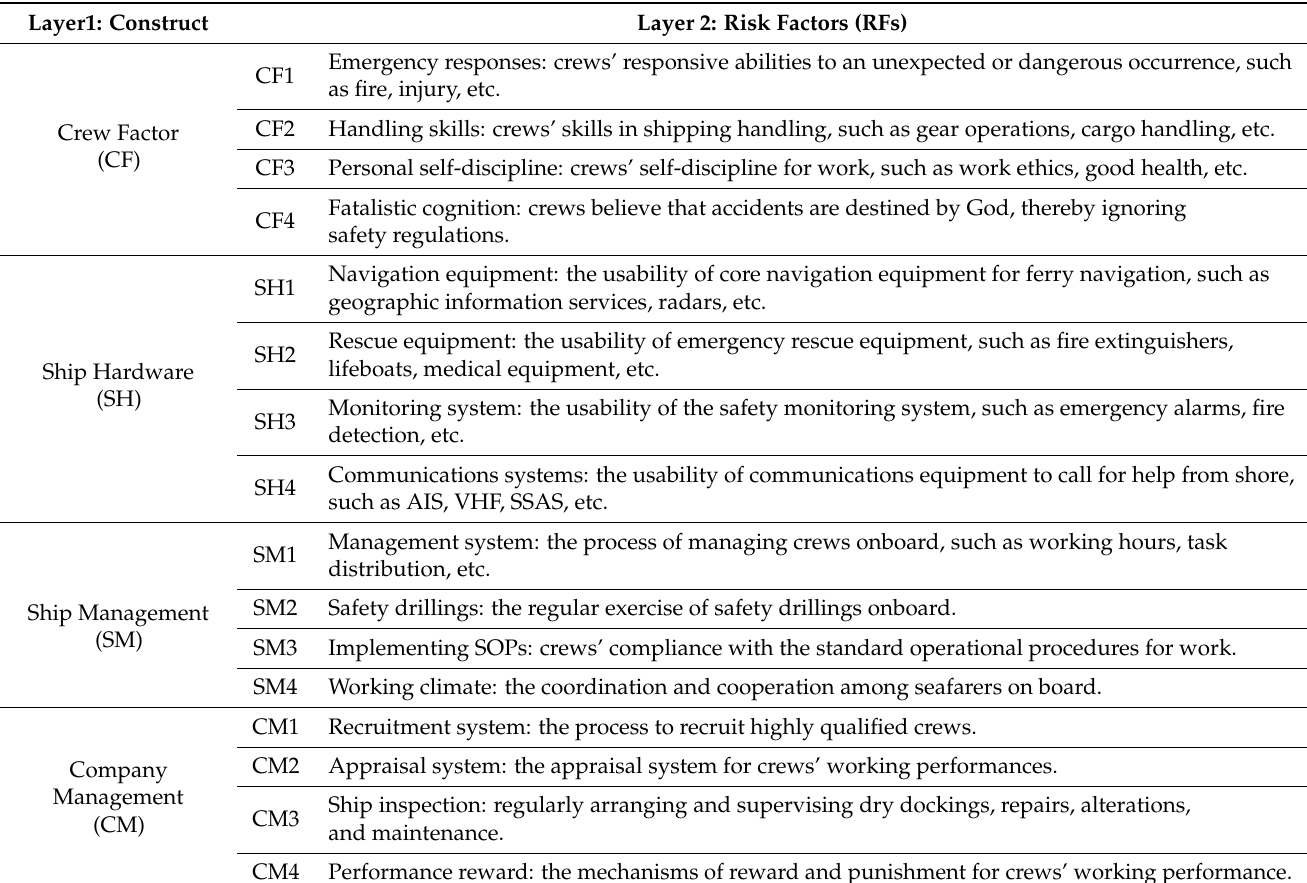
Table 2. The risk factors (RFs) for ferry navigation